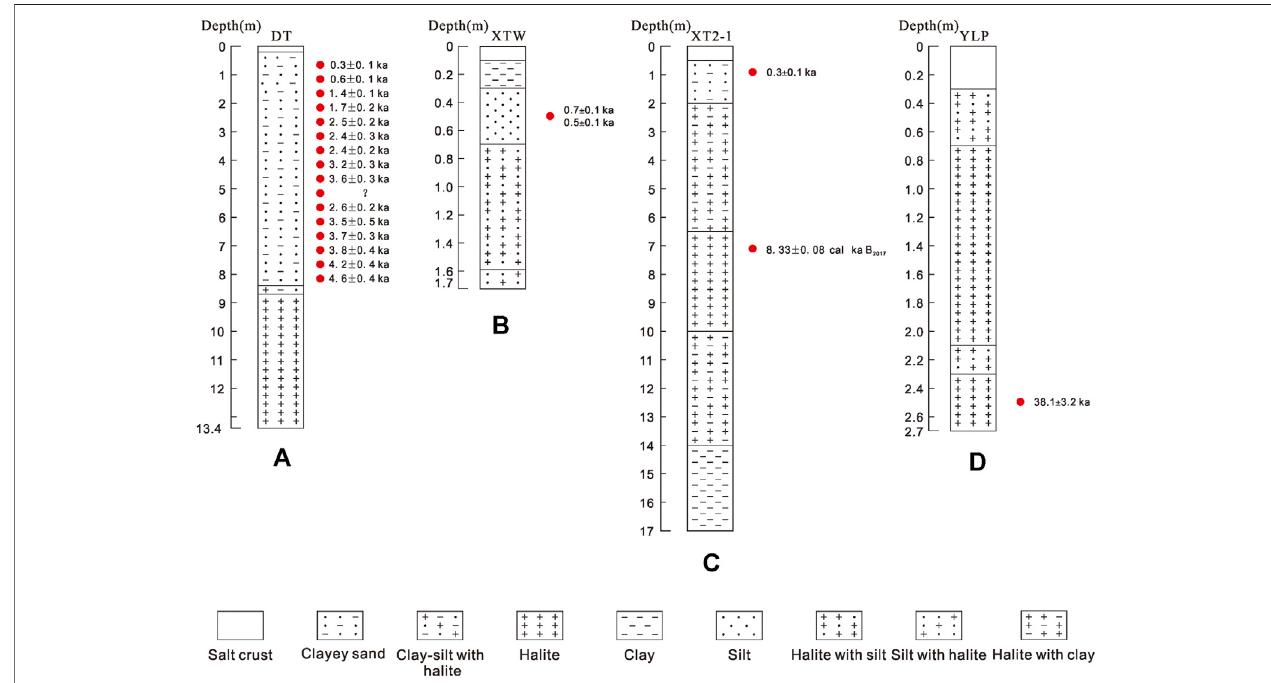
FIGURE 4 | Stratigraphy, OSL sample site, and dating results for the Three Lakes: (A) Section DT in East Taijnar Salt Lake; (B) Section XTW in West Taijnar Salt Lake; (C) Section XT2-1 in West Taijnar Salt Lake (Wang et al., 2019); and (D) Section YLP in Yiliping Salt Lake.